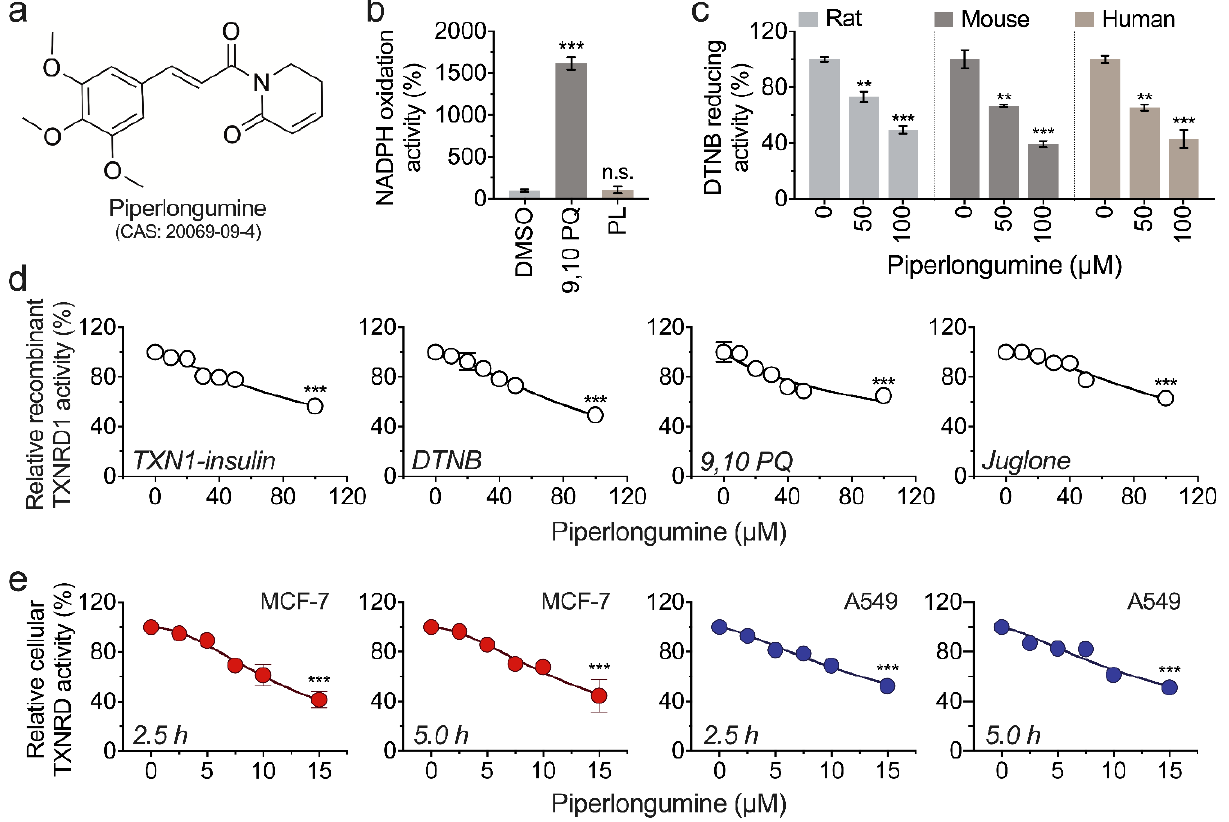
Figure 1. Piperlongumine inhibits TXNRD1 activity. ( a ) The chemical structure of piperlongumine (PL). ( b ) Piperlongumine is not a proper substrate of TXNRD1. The NADPH oxidation activity of 30 nM TXNRD1 in the presence of 200 µM NADPH and 30 µM piperlongumine or 9,10 PQ (DMSO as control) were measured, respectively. ( c ) Piperlongumine inhibits three species of recombinant TXNRD1. Human TXNRD1 (0.4 µM), rat TXNRD1 (0.2 µM), and mouse TXNRD1 (0.3 µM) were